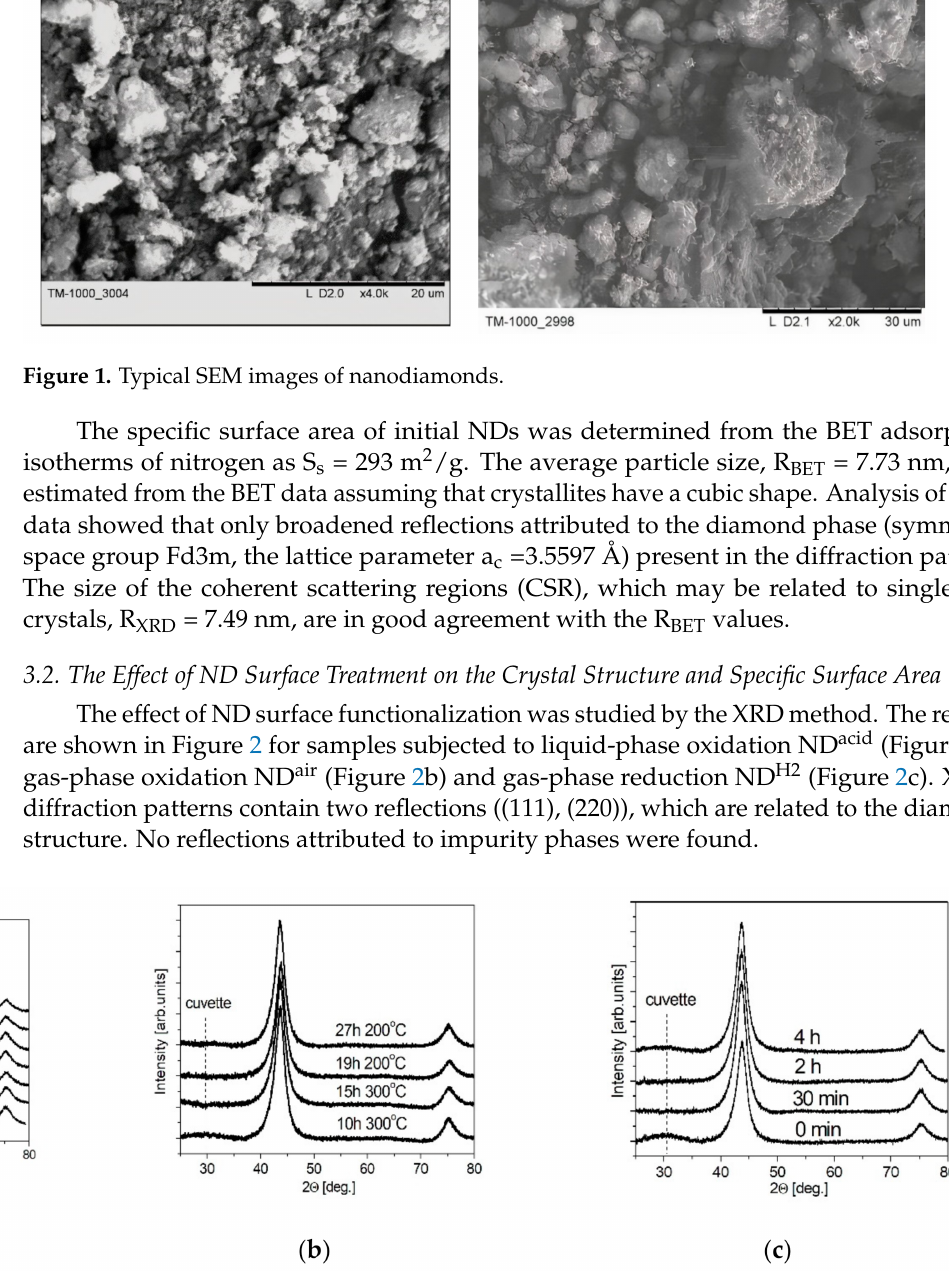
Figure 2. XRD patterns of the samples ND acid ( a ), ND air ( b ) and ND H2 ( c ). Experimental values of CSR estimated using the Scherrer formula and specific surface area are listed in Table 1. CSR values, R XRD , in functionalized NDs were 4.2–4.6 nm for liquid-phase oxidation, 4.0–4.7 nm for gas-phase oxidation and 3.8–5.1 nm for gas-phase reduction. For all types of ND functionalization, CSR values increased with the functional- ization time. During oxidation, the bulk diamond phase “burns out”, since the